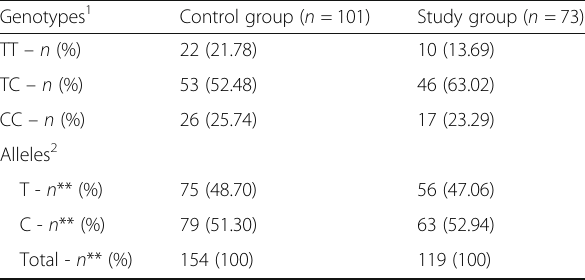
Table 4 Frequency distribution of the genotypes of the Pvu II polymorphism in patients with precocious puberty and